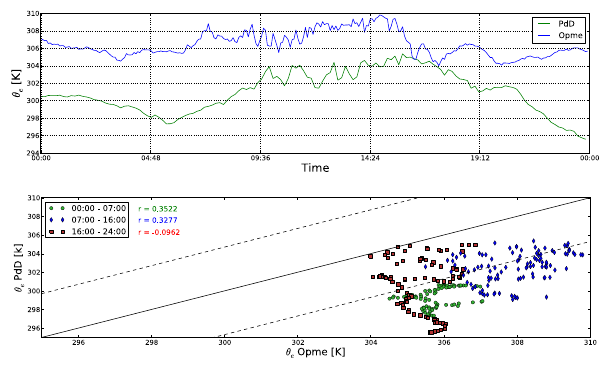
Fig. 13. Temporal evolution of equivalent potential temperature at both sites during a non-simultaneous nucleation event (“D D ”, 21 May 2010).